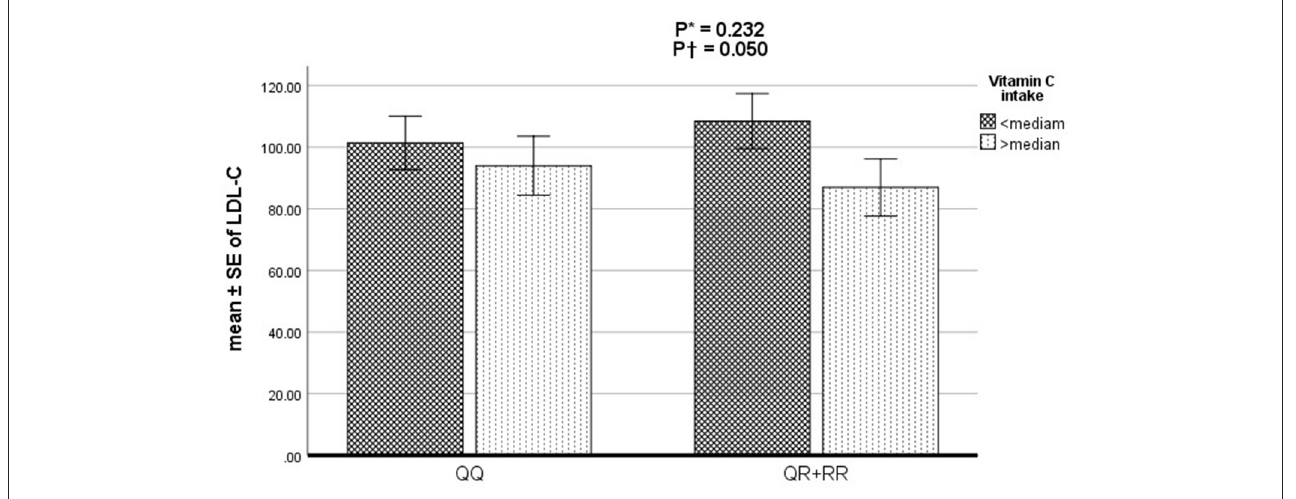
FIGURE1 Interaction of PON1 rs662 polymorphism and vitamin C intake on serum